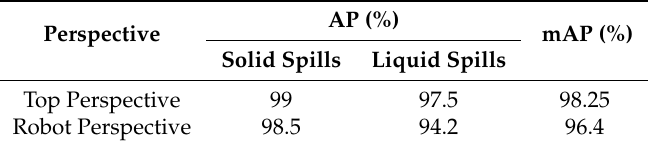
Table 1. AP and mAP for the proposed scheme.